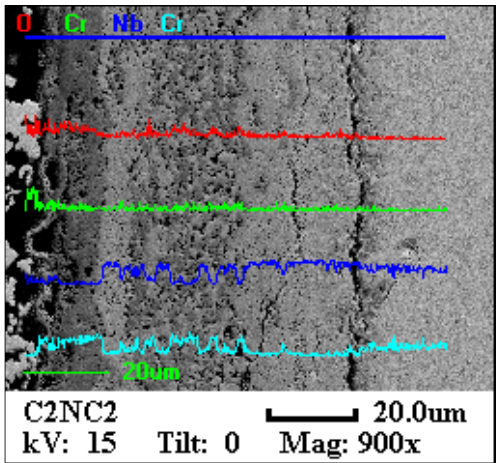
Figure 11. Line scan of the presence of elements in samples.